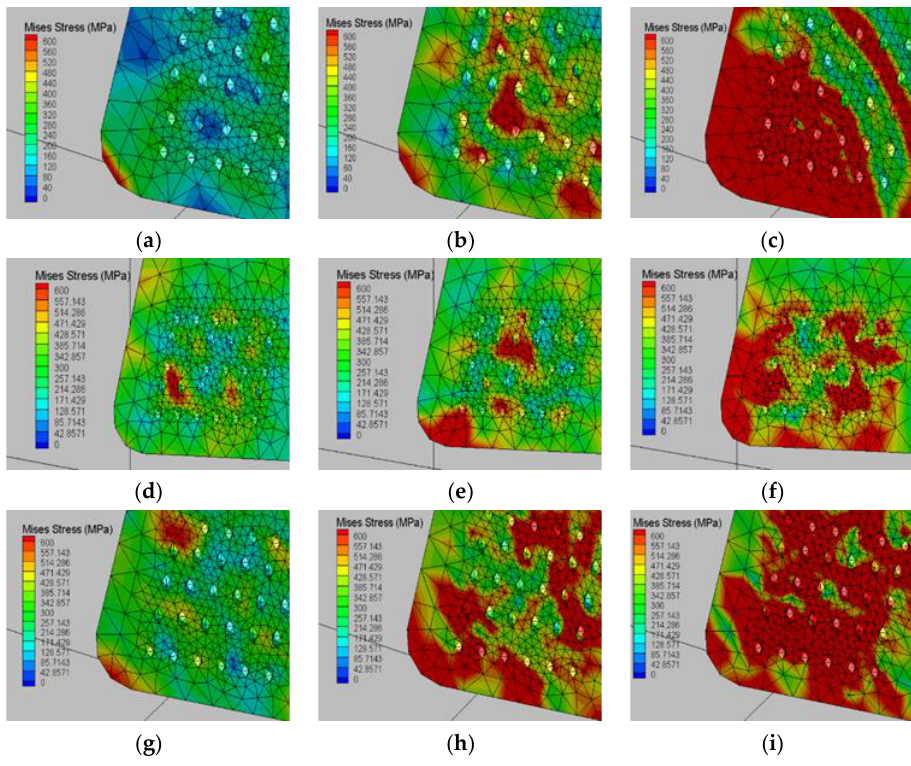
Figure 12. Comparison of main cutting force and radial force. Figure 13 is the stress distribution diagram during the cutting process of the compo- site micro − textured tool. Figure (a), (d) and (c) are the tool stress distribution at the be- ginning of cutting. (b), (e) and (h) are the tool stress distribution maps for stable cutting; (c), (f) and (i) are the tool stress profiles at the end of the cutting process. It can be seen from the figure that with the cutting process, the stress gradually spreads to the inside of the tool front face and gradually transfers to the micro − textured position. Comparing the stress nephogram of three kinds of composite micro − texture tools, it is found that the secondary stress of composite micro − texture is concentrated at the micro − texture posi- tion far away from the tool tip and the main cutting edge, and the stress value is the small- est. It can be concluded that the stress absorption effect of composite micro − texture II is significantly better than that of the other two micro − texture tools.